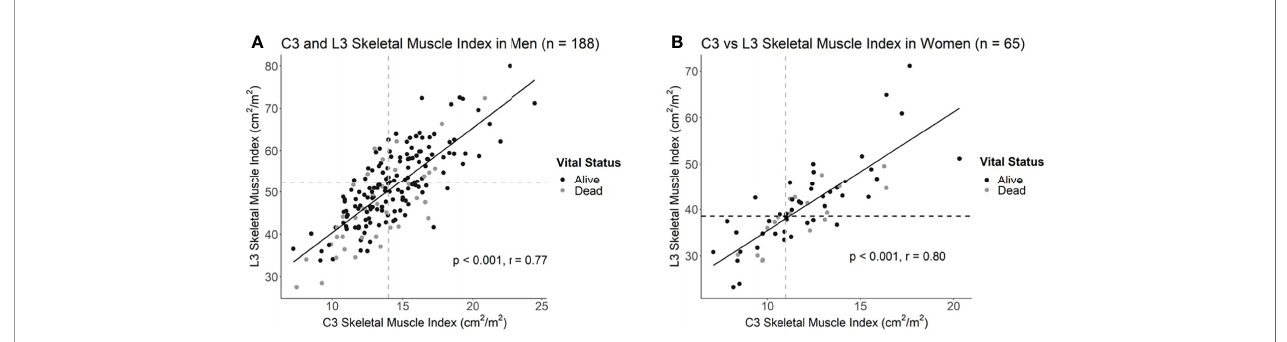
FIGURE 2 | Correlation plots of L3 and C3 skeletal muscle indices in (A) men and (B) women with head and neck cancer. Dotted lines delineate the intersection of previously established L3 sarcopenia thresholds with the estimated C3 sarcopenia